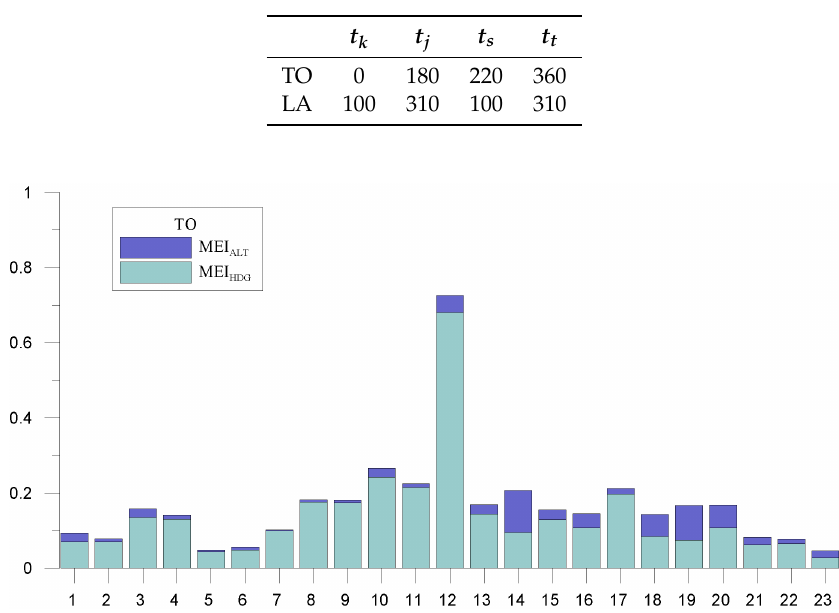
Table 2. Time values in seconds for evaluation of MEI within TO and LA.